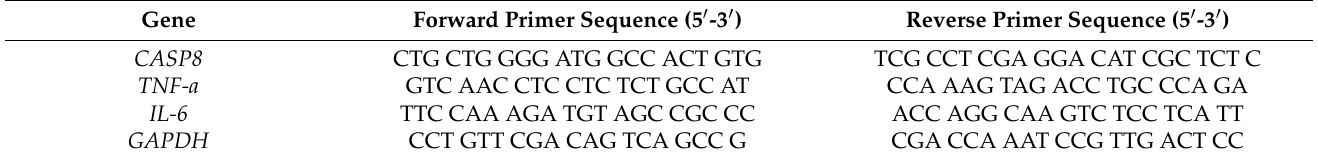
Table 3. List of primers for qPCR